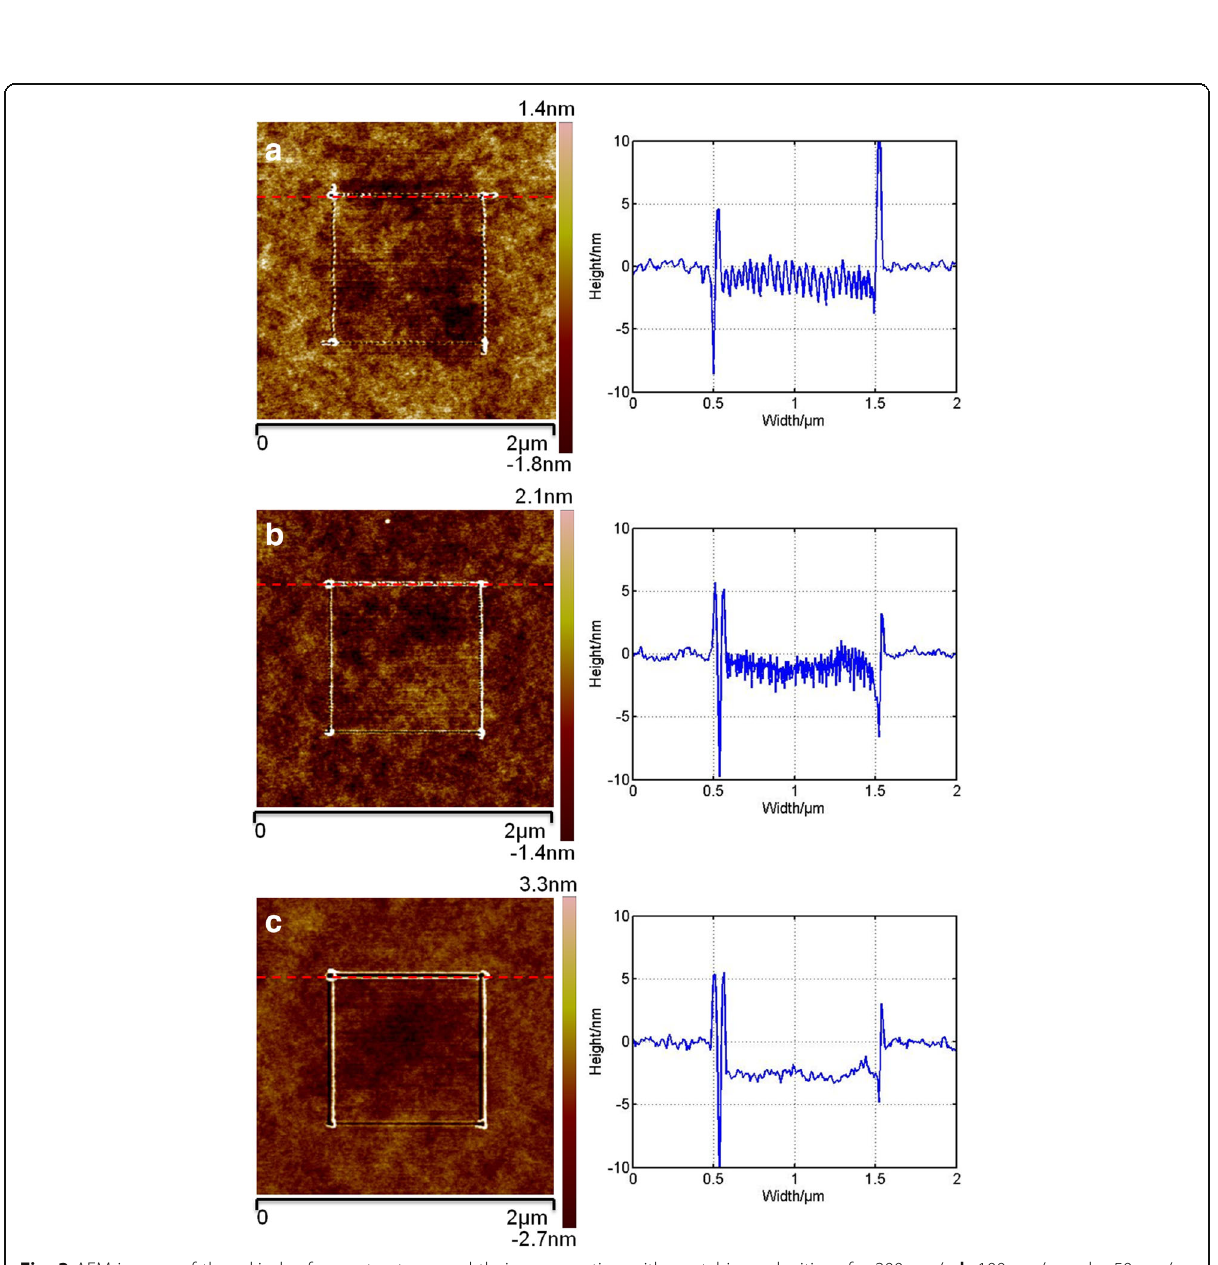
Fig. 3 AFM images of three kinds of nanostructures and their cross-section with scratching velocities of a 200 μ m/s, b 100 μ m/s, and c 50 μ